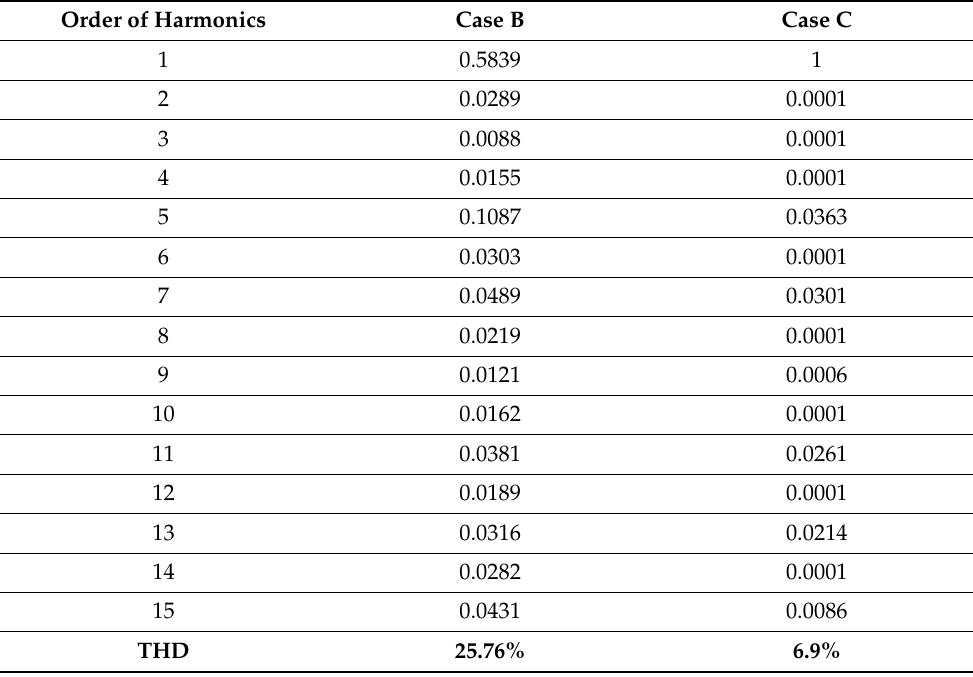
Table 2. Comparison of harmonic components of PCC voltage in cases B and